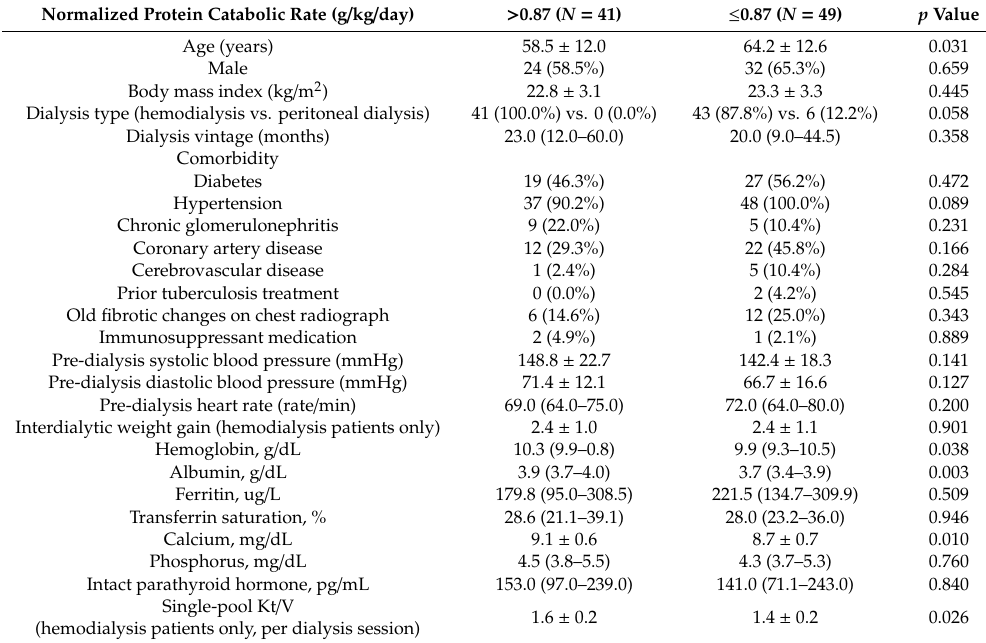
Table 3. Baseline characteristics of the groups according to normalized protein catabolic rate. Normalized Protein Catabolic Rate (g / kg /